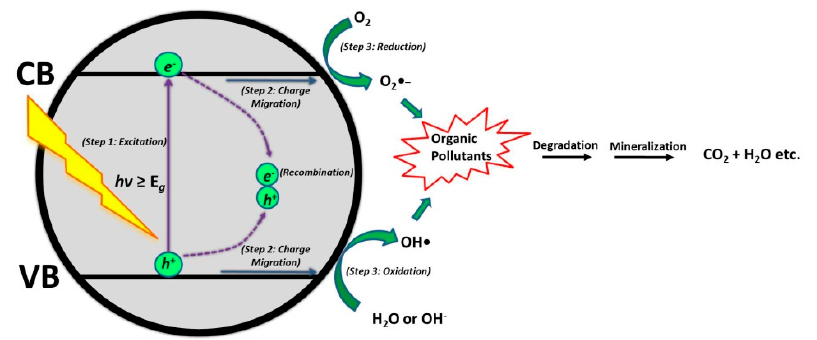
Figure 1. Photocatalytic reaction mechanism over semiconductor material.